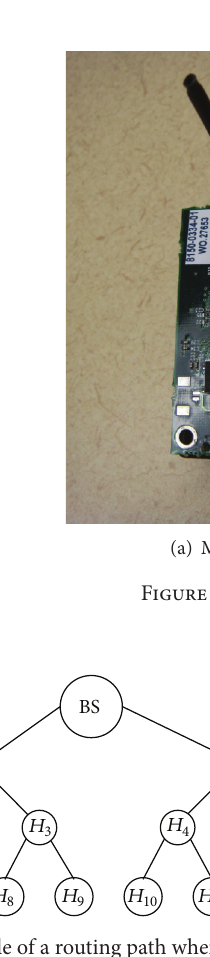
Figure 5: Example of a routing path where 𝑑 = 2 and ℎ = 4 .